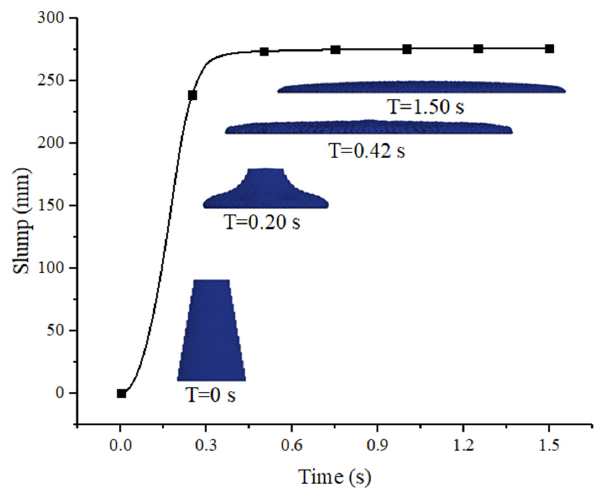
Figure A2. The numerical time-history of the slump.